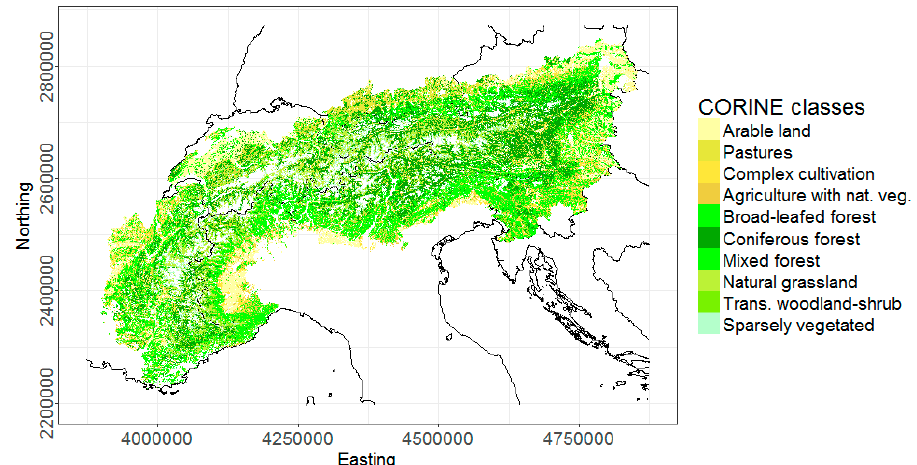
Figure 2. Selected land cover classes of the COoRdination of INformation on the Environment (CORINE) Land Cover product over the Alps.